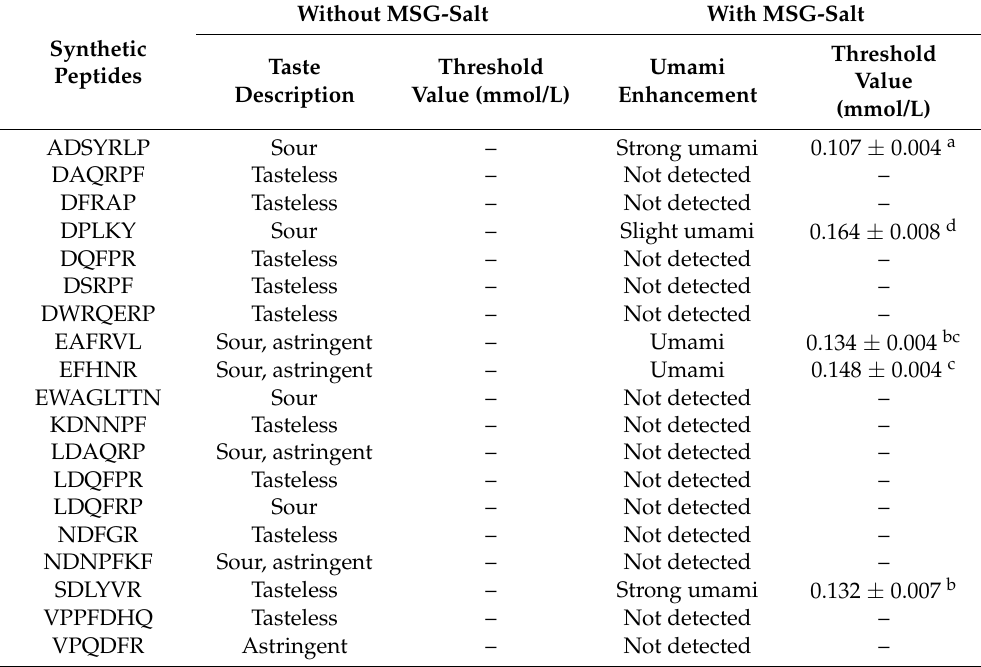
Table 5. Descriptive sensory evaluation of synthetic peptides and their MSG-enhanced